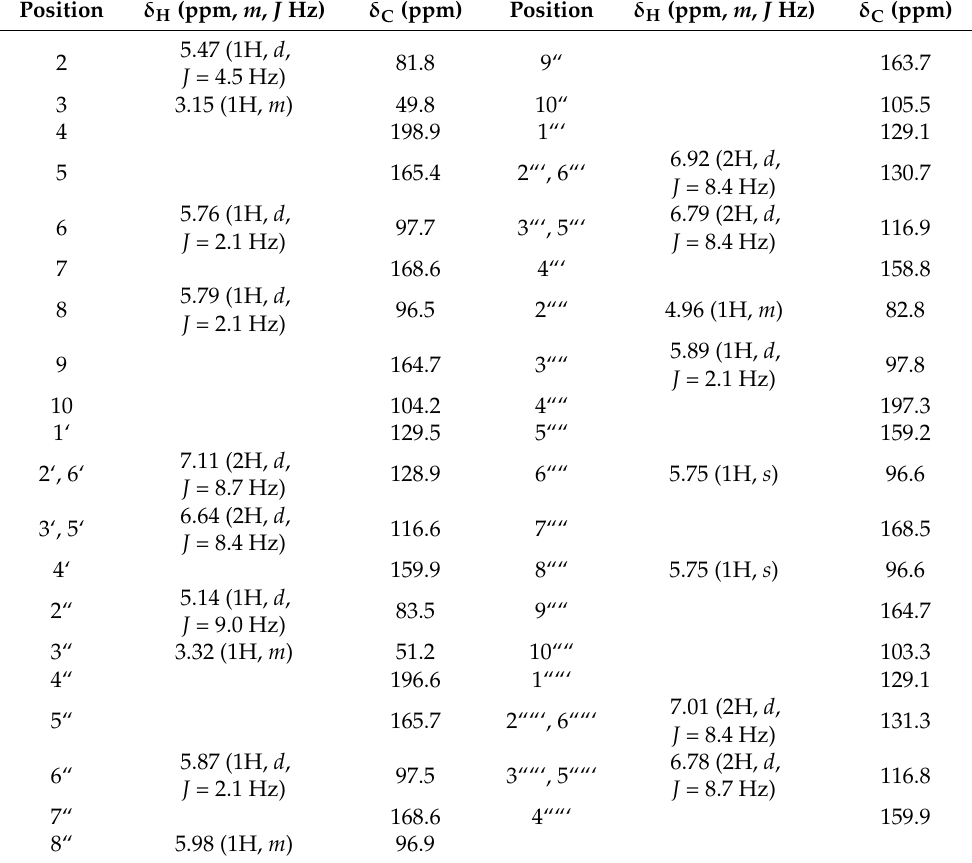
Table 1. 1 H-NMR (300 MHz) and 13 C-NMR (100 MHz) in CD 3 OD spectra data of compound 1